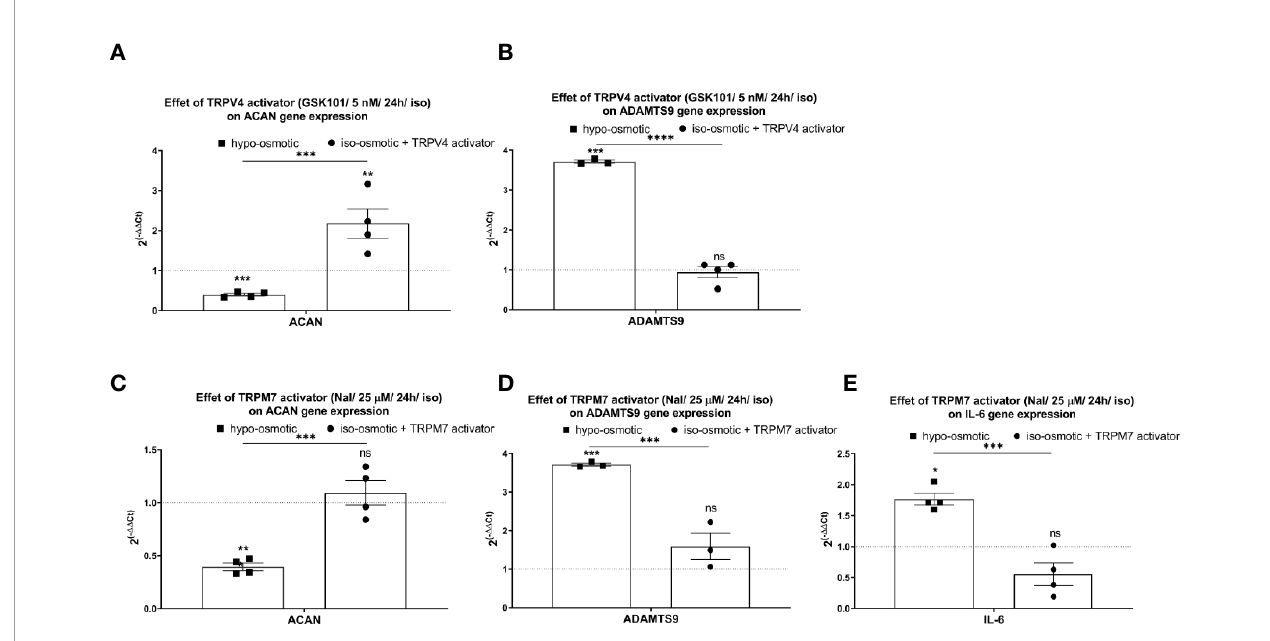
FIGURE 7 | The mRNA expression of (A) aggrecan (ACAN) and (B) ADAMTS9 in NP cells after 24 h of treatment with TRPV4 activator (5 nM GSK1016790A); (C) aggrecan (ACAN), (D) ADAMTS9, and (E) IL-6 in NP cells after 24 h of treatment with TRPM7 activator (25 µM Naltriben). Graphs show 2 − DD Ct values normalized to the iso-osmotic control (mean ± SEM, bNP P2, n = 3 – 4). Asterisks indicate statistical signi fi cance (*p < 0.05, **p < 0.01, ***p < 0.001, ****p < 0.0001, ns , no statistical difference de fi ned at p > 0.05) between hypo-osmotic group, iso-osmotic group or iso-osmotic activator-supplemented